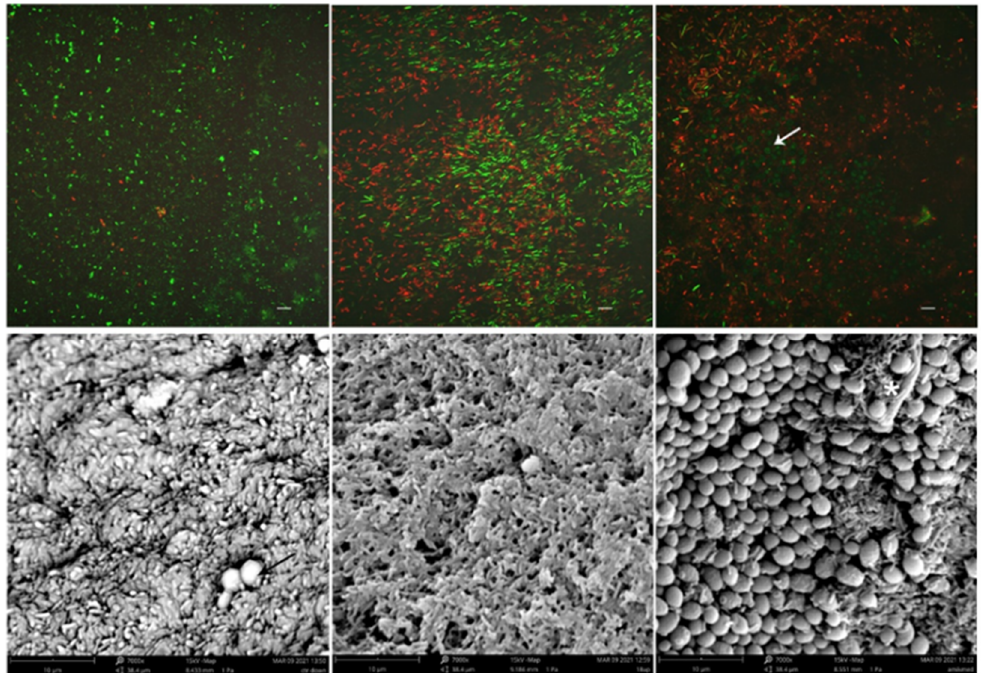
Figure 3. Representative images by CLSM ( upper ) and SEM ( lower ) of LCW mature biofilm. Left panels, untreated control; central panels, L18R-treated samples; right panels, amikacin-treated samples. In control samples, viable bacterial cells (coccoid and rod-shaped green cells in CLSM) are detected, with only a few cells of C. albicans (black arrow in the SEM image). After L18R treatment, dead and viable bacterial cells are the main components of the CLSM image. Rod shaped P. aeruginosa cells are also predominant on SEM observation. In the amikacin-treated samples, the number of C. albicans cells increases with viable yeast cells (white arrow in CLSM image) embedded in a prevalent dead bacterial population and rare pseudohyphae (asterisk) detectable by SEM. CLSM magnification 1.000× (bars = 5 μm), SEM magnification 7.000 × (bars = 10 μm).